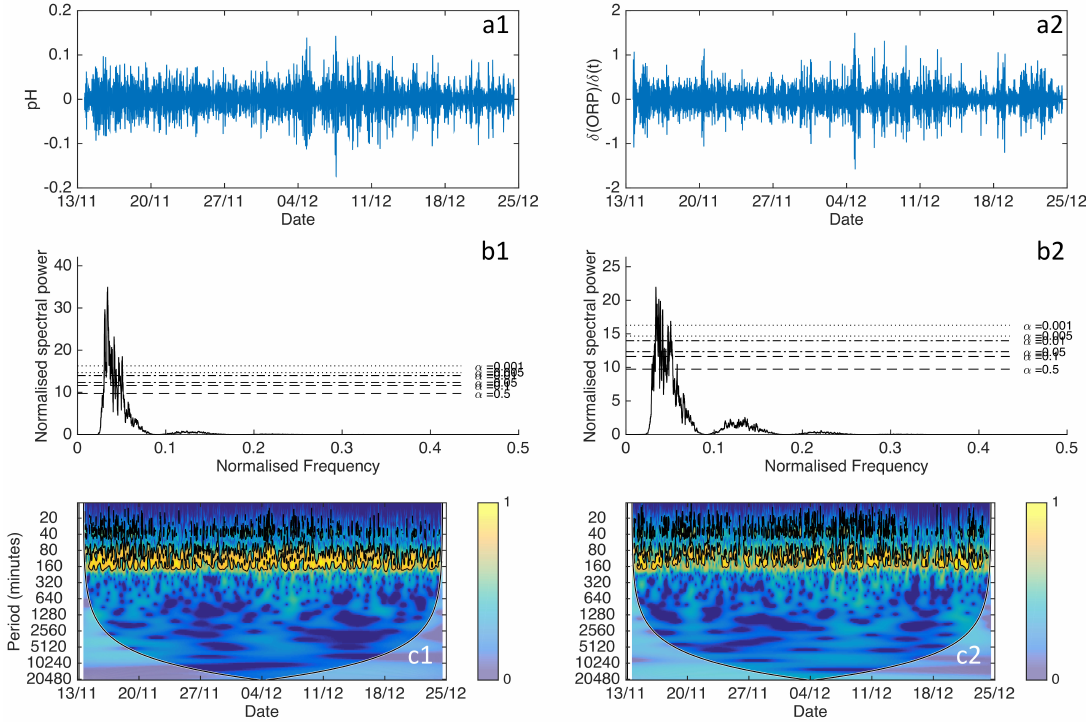
Figure 6. Filtered time series of pH ( a1 ) and ∂ (ORP)/ ∂ t ( a2 ) from a pH-ORP sensor mounted in a mooring at theinteriorof the main crater ata 127m depth. ( b1 – b2 )are thecorrespondingpower spectraand statistical significance computed by fast Fourier transform (FFT). ( c1 – c2 ) are the implementation of the wavelet transform. The solid contour shows the 95% confidence interval and the light shaded region the cone of influence, representing the area where the wavelet spectrum is affected by edge